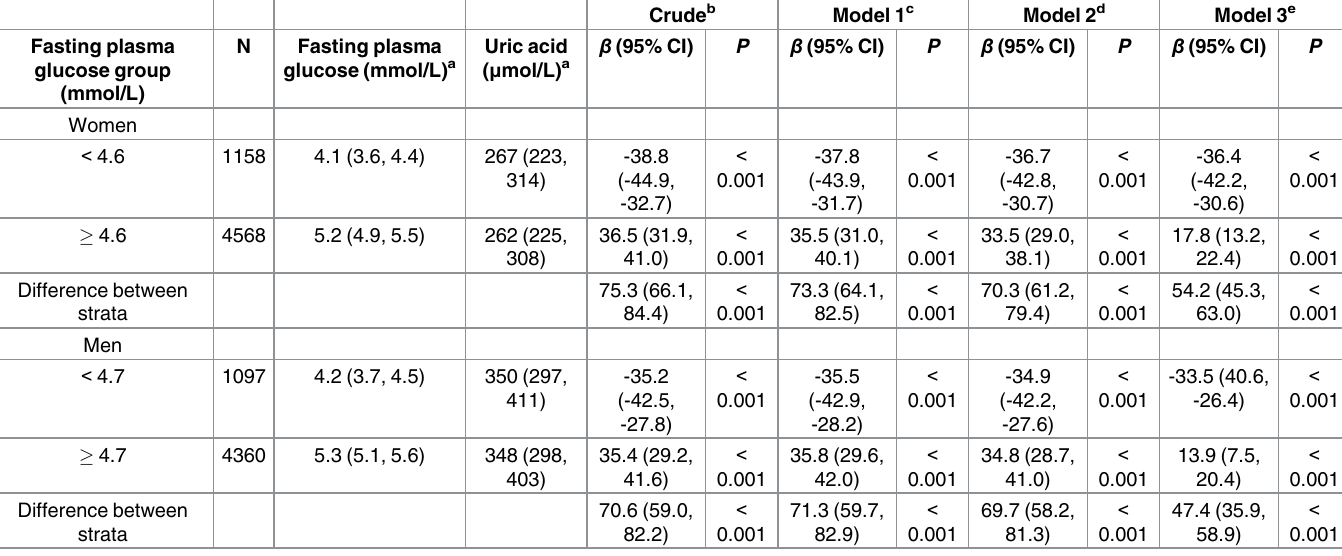
Table 2. Linear regression analysesbetween fasting plasma glucose and serum uric